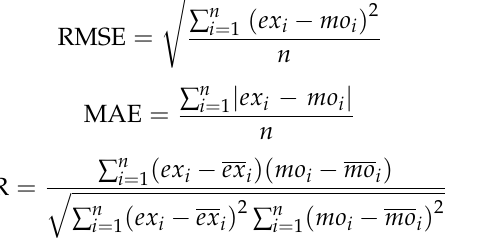
Table 2. Results of the CV of k-fold for the employed models.